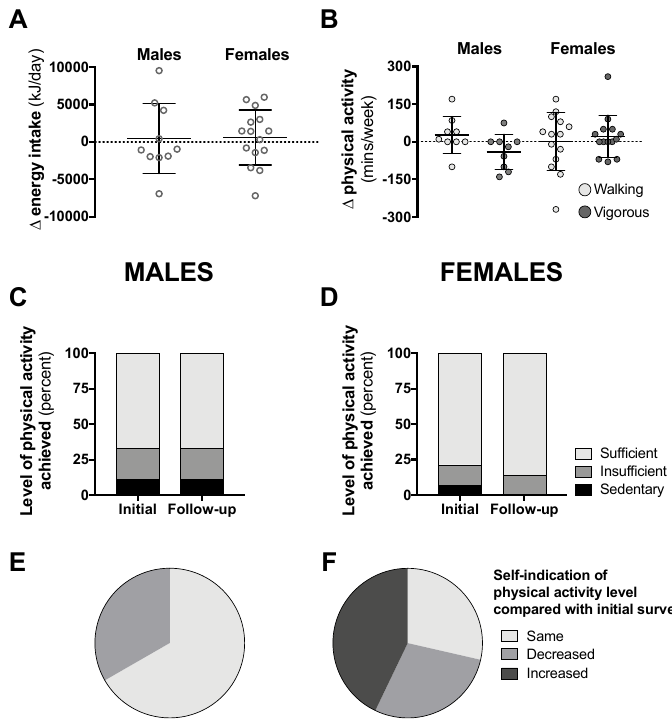
Figure 6. Changes in total 24-h energy intake ( A , n = 10 males, 15 females) and time spent in walking or vigorous activity ( B ), proportion of students achieving “sufficient” physical activity levels ( C , D ),